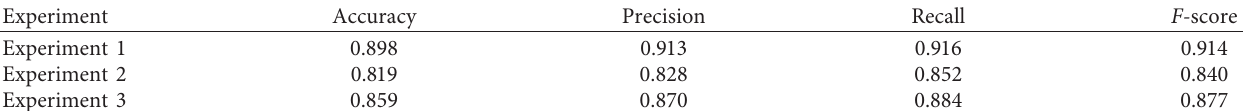
Table 3: Performance comparison of the proposed fake news detection model for different experiments.